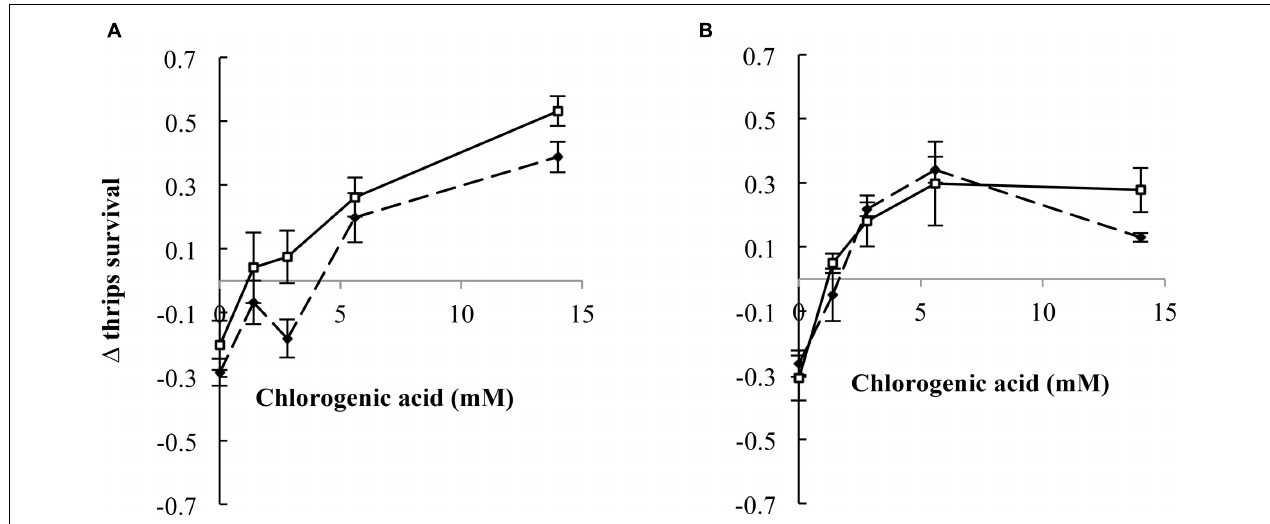
FIGURE 6 | (cid:49) thrips survival (thrips survival for the combination of free base PAs with CGA minus thrips survival for the combination of PA N -oxides with CGA ( ± 95% confidence interval) against CGA concentration. (A) Retrorsine, (B) jacobine. Dashed lines: PA concentration of 4 mM, solid lines: PA concentration of 7